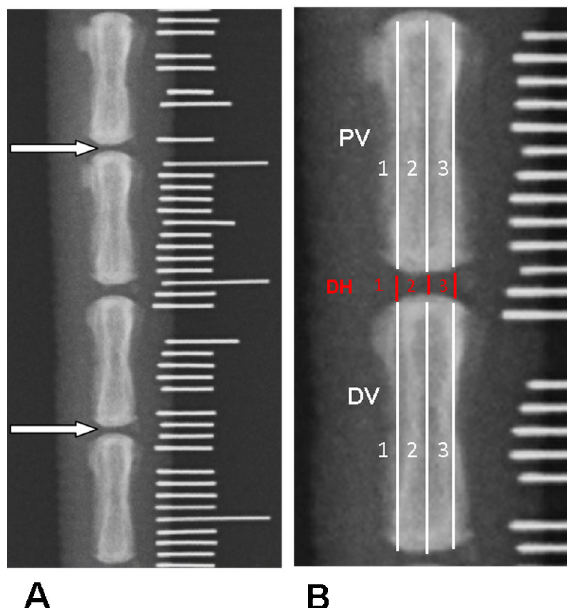
Figure 1. T2-weighted magnetic resonance imaging (MRI) of intervertebral discs. A , Normal discs before lesion. B , Punctured discs 30 days after lesion. The first arrow indicates the distal segment (Co8-9) and the second one the proximal segment (Co6-7). C , ImageJ analysis. D , The x-axis indicates the distance measured in millimeters and the y-axis indicates mean MRI intensity profile along the yellow line. The peak value (± 60) indicates the control segment and the depressions of the curve indicate the punctured segments marked by dashed lines on the graph. The results were normalized according to the respective control.